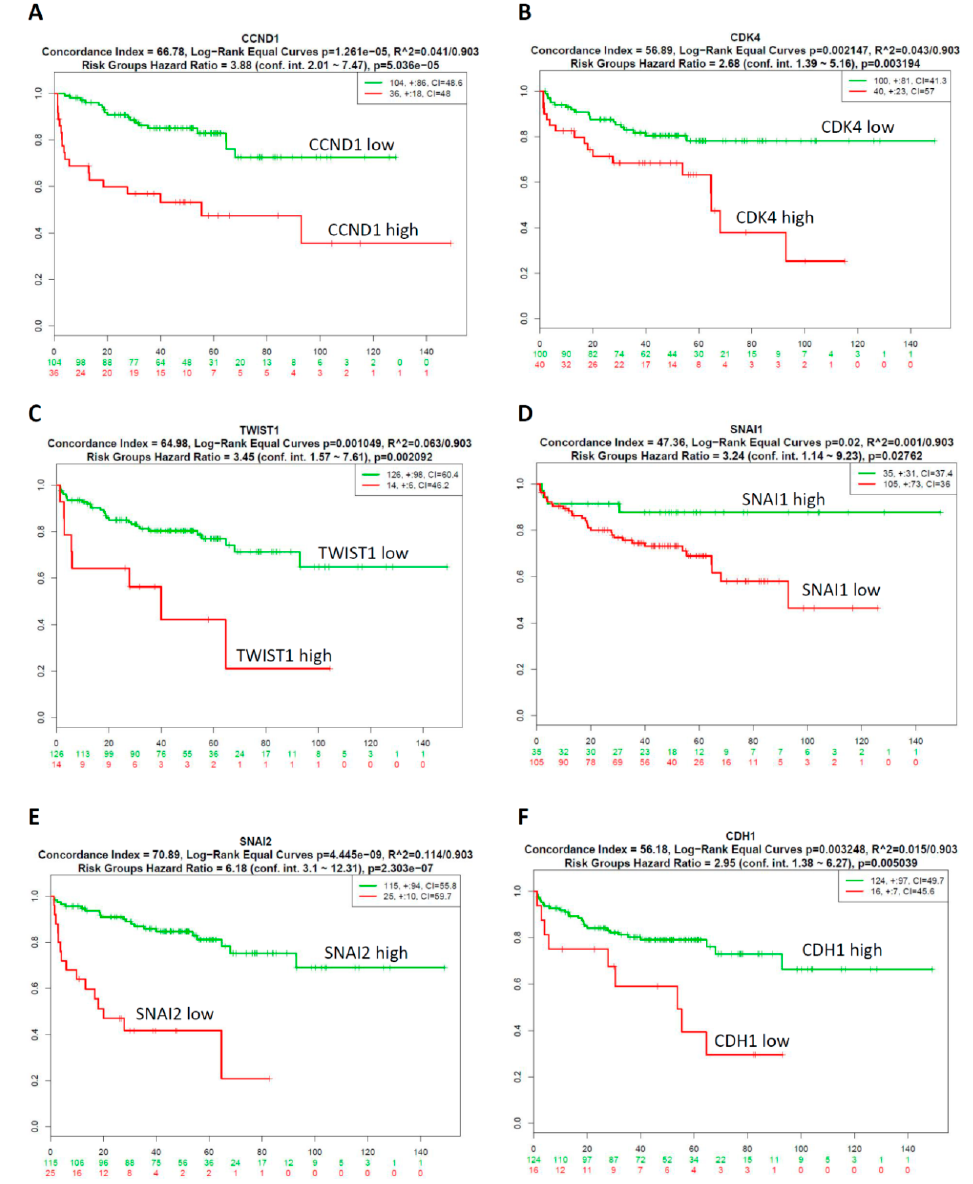
Figure 4. Correlation between GA-modulated cell-cycle-related genes or EMT-related genes expression and the survival rates in prostate cancer patients. Low expression of CCND1 ( A ), CDK4 ( B ), and TWIST1 ( C ) were correlated with longer survival time of prostate cancer patients. High expression of SNAI1 ( D ), SNAI2 ( E ), and CDH1 ( F ) were correlated with longer survival time of prostate cancer patients. Green and red lines indicate low- and high-risk groups, respectively. P < 0.05 was considered to be statistically significant.